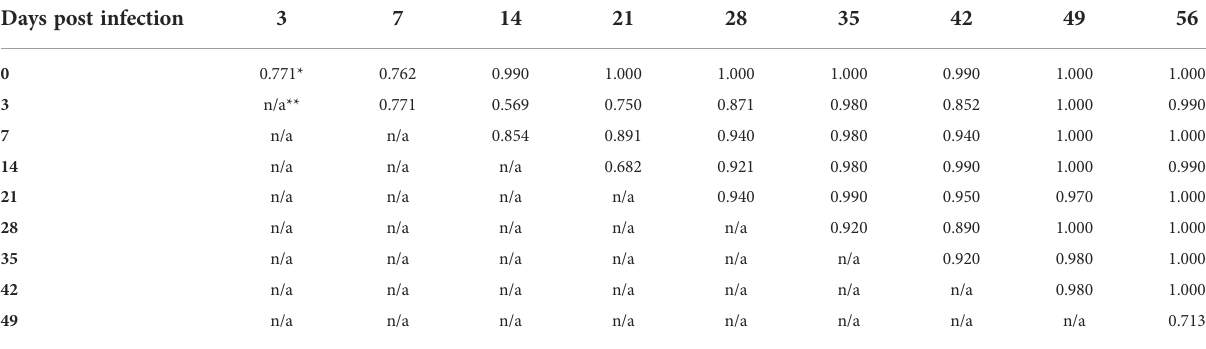
Days post infection